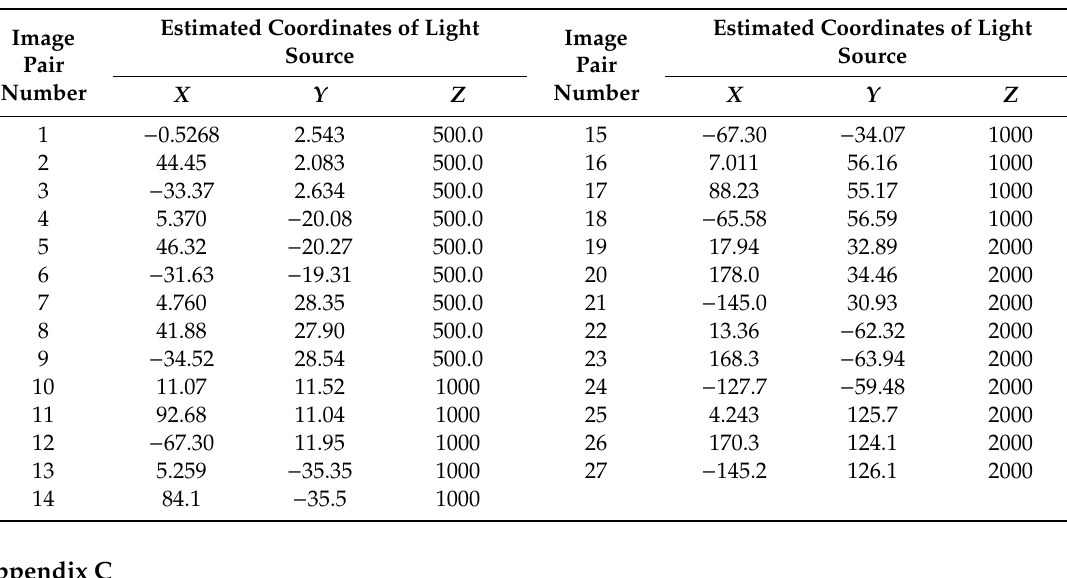
Table A1. Coordinates of the light source estimated as described in Section 3.3. All values are expressed using four significant figures.